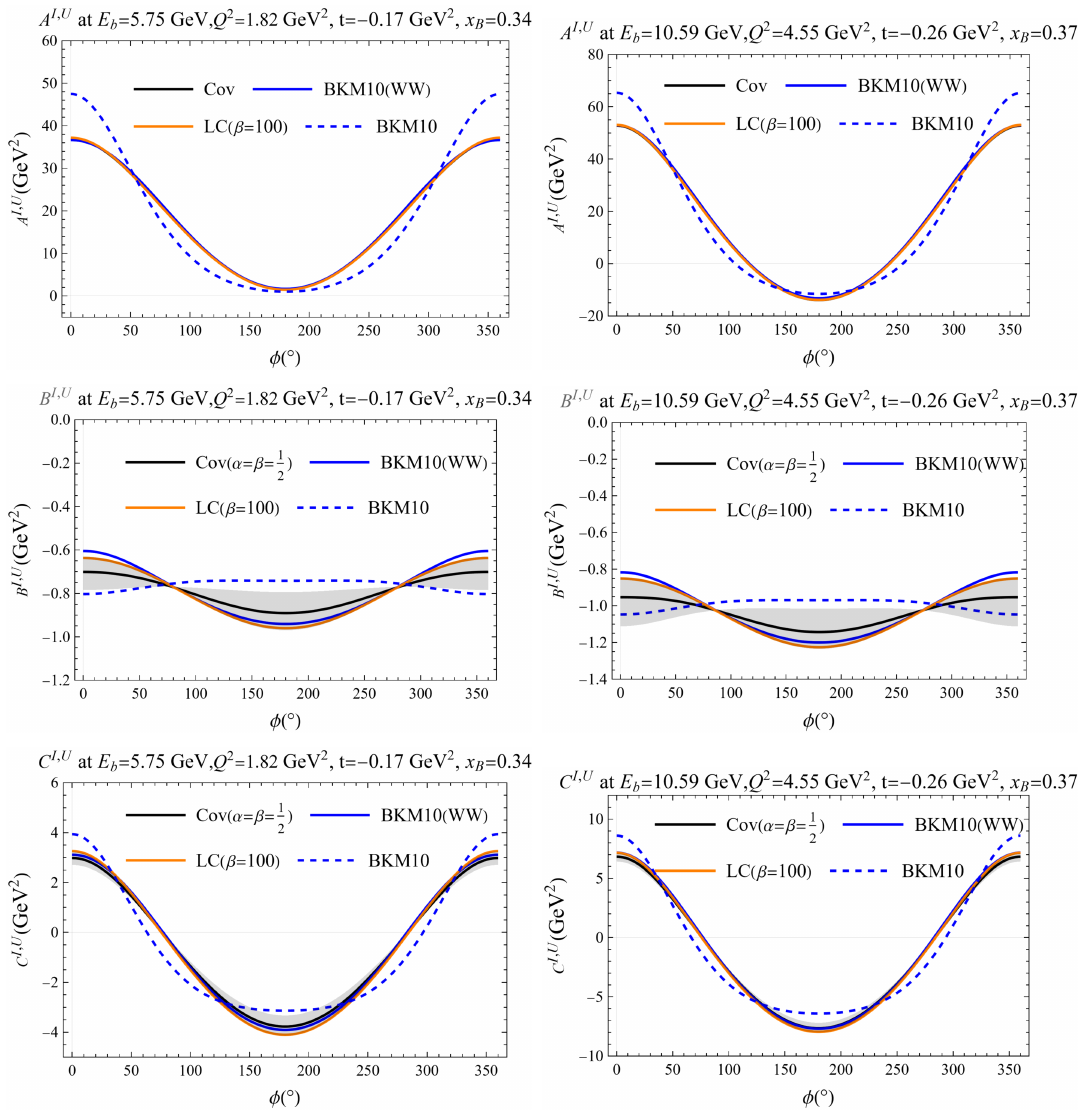
Figure 12 . A comparison of the coefficients A I,U , B I,U and C I,U over different formulas. The coefficients B I,U and C I,U depend on the light cone vectors explicitly, and thus we vary the α and β from 0 ≤ α ≤ 1 and 0 ≤ β ≤ 100 to get the gray band in the plot. The blue lines in the plot agree well with each